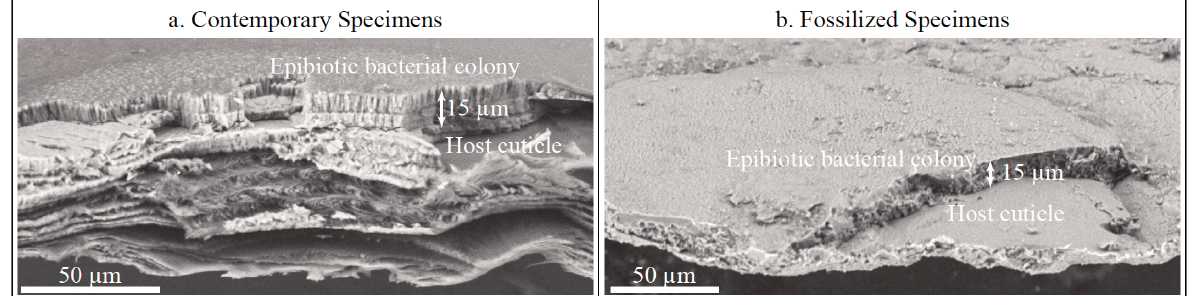
Figure 4. Thicknesses of the investigated contemporary and fossilized epibiotic calcifying bacterial colonies. ( a ) SEM image (secondary electrons) of a section of a contemporary specimen. ( b ) SEM image (secondary electrons) of a section of a fossilized